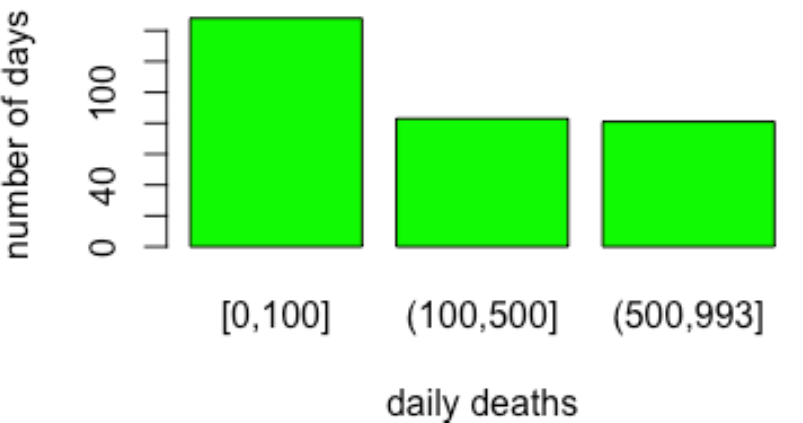
Figure 7. Discretisation results for COVID-19 death variables in Italy. Class limits are reported on the x -axis.